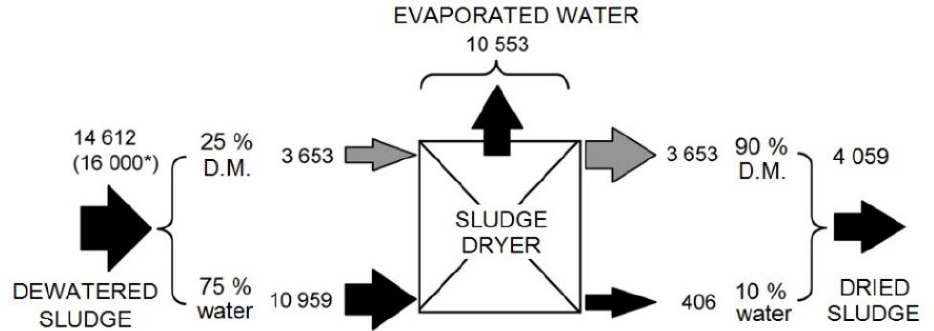
Figure 2. Annual balance of drying of dewatered digested sewage sludge, Mg/year . The availability factor of a drying plant has been assumed at the level of 0.913 which corresponds to about 8000 h of operation within a year. Volumes of sewage sludge and water presented in Figure 2 result from a conversion of input value of annual dewatered sludge (16,000 Mg) to corrected values regarding the availability factor. As a result, de- watered sewage sludge which is annually produced (16,000 Mg) corresponds to 14,612 Mg of sludge which is going to be dried and 10,553 Mg of water evaporated during the drying process.